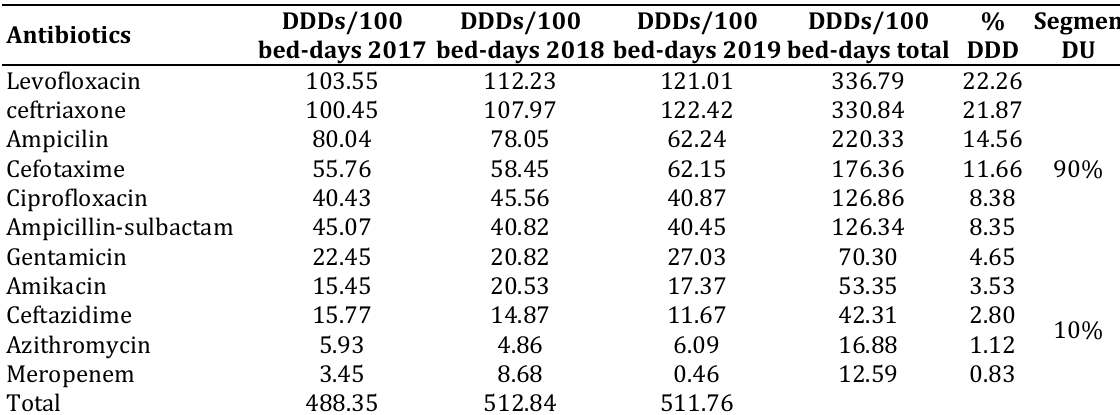
Table I. Antibiotic consumption in the inpatient regional public hospital during 2017-2019 Antibiotics